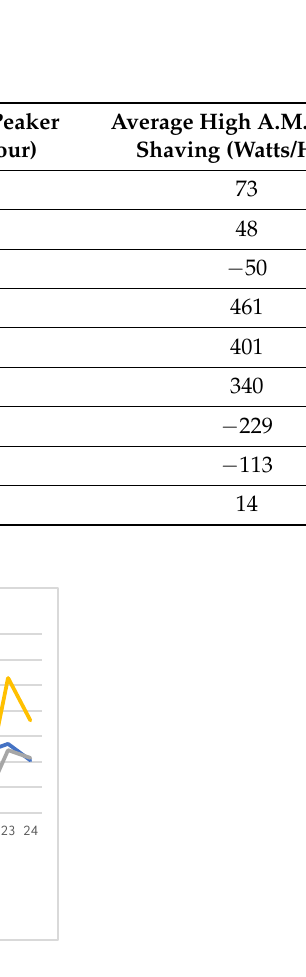
Table 7. Example Results from Smart Strategy.